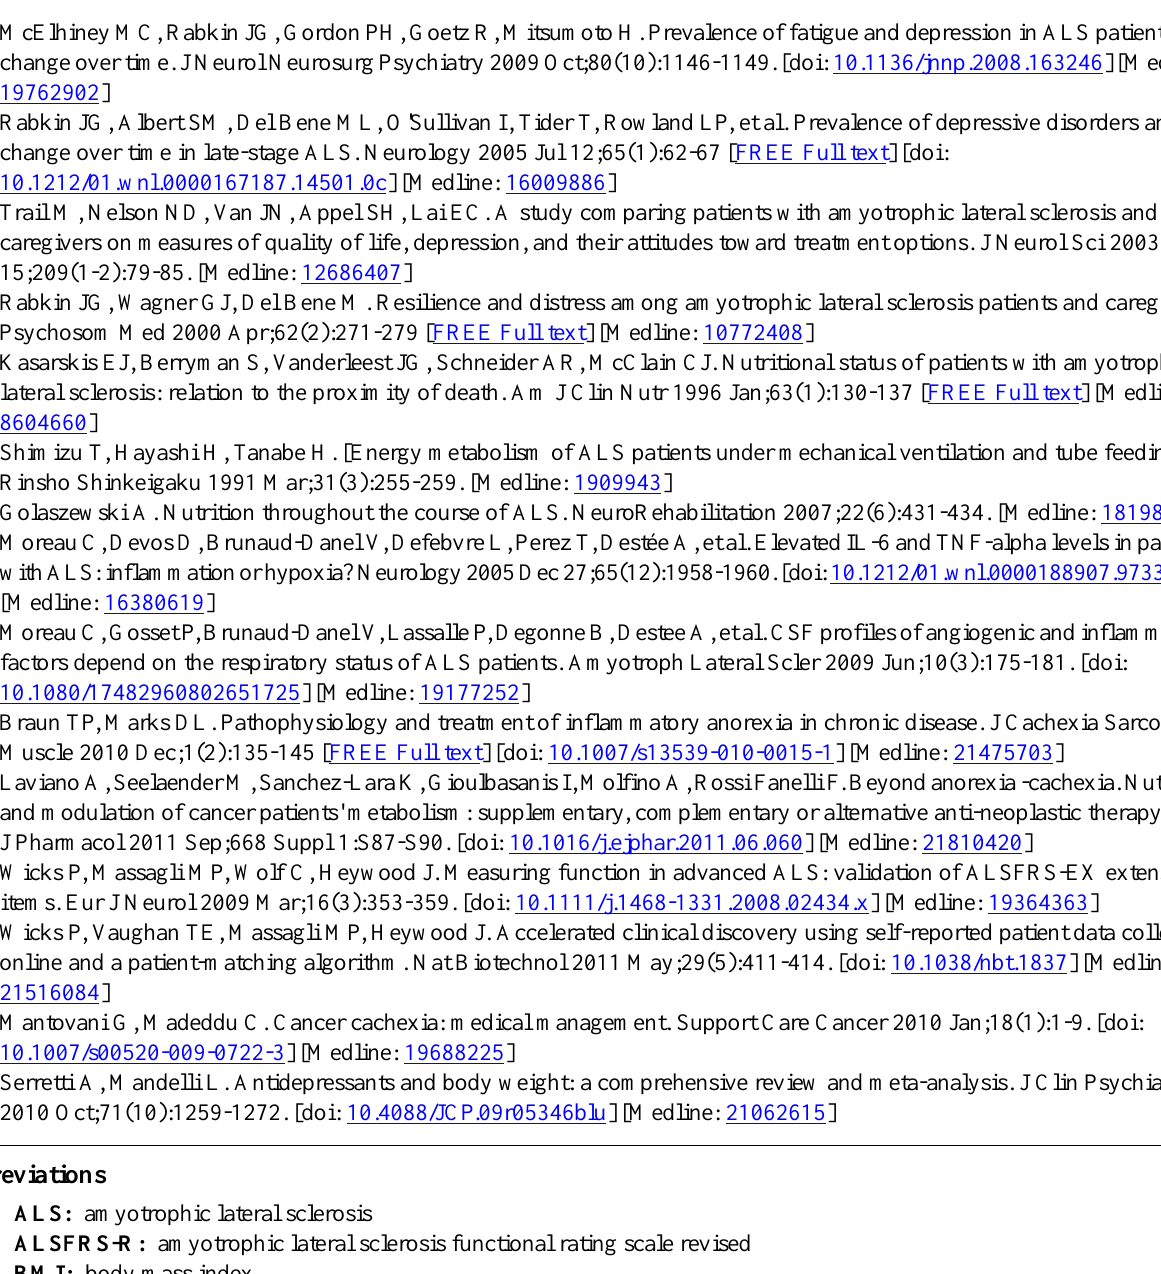
ALS: amyotrophic lateral sclerosis ALSFRS-R: amyotrophic lateral sclerosis functional rating scale revised BMI: body mass